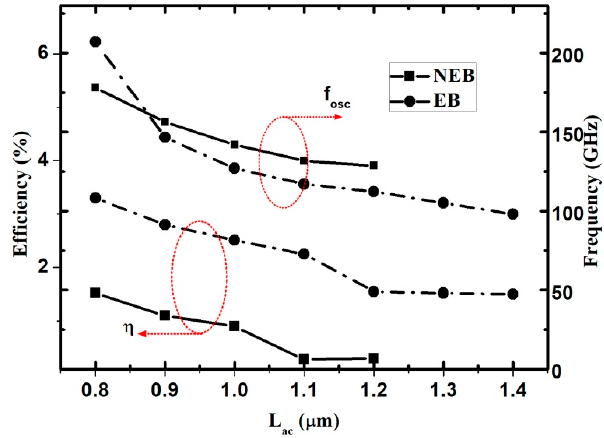
Figure 9. Simulation results of the oscillation frequency f osc and dc-to-ac conversion efficiency η versus the active region length L ac under EB and NEB models.